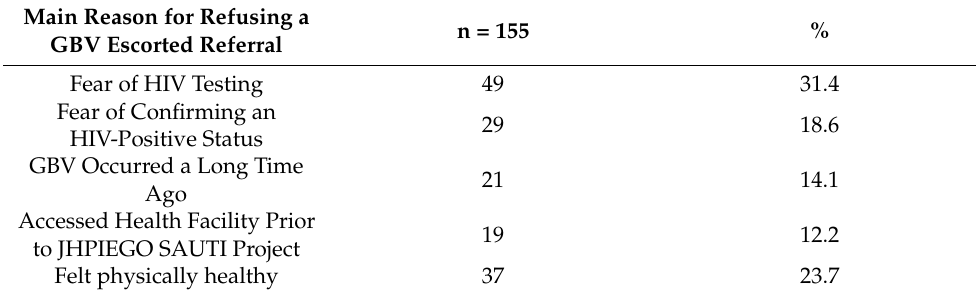
Table 4. Reasons for refusing escorted referral to GBV services following SBCC